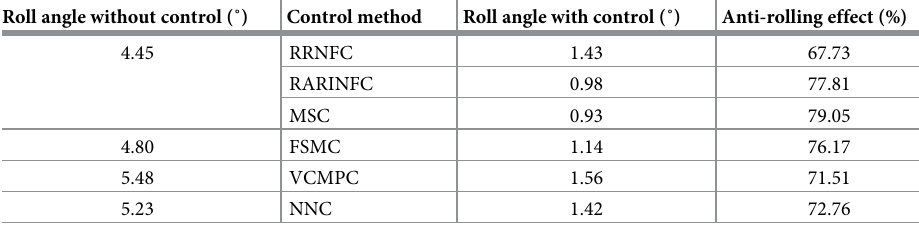
Table 4. Performance of zero-speed fin